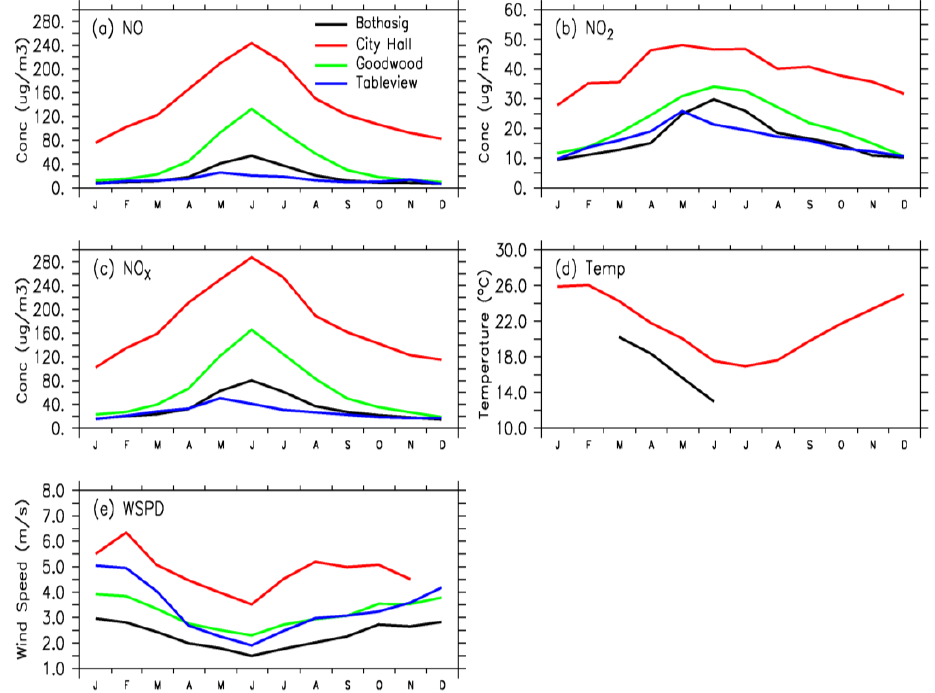
Fig. 5. The monthly mean of observed (a) NO, (b) NO 2 , (c) NO x , (d) Temperature, (e) wind speed, and (d) wind direction at four monitoring Figure 5: The monthly mean of observed (a) NO, (b) NO stations in Cape Town speed, and (d) wind direction at four monitoring stations in Cape Town (2001 -2008).